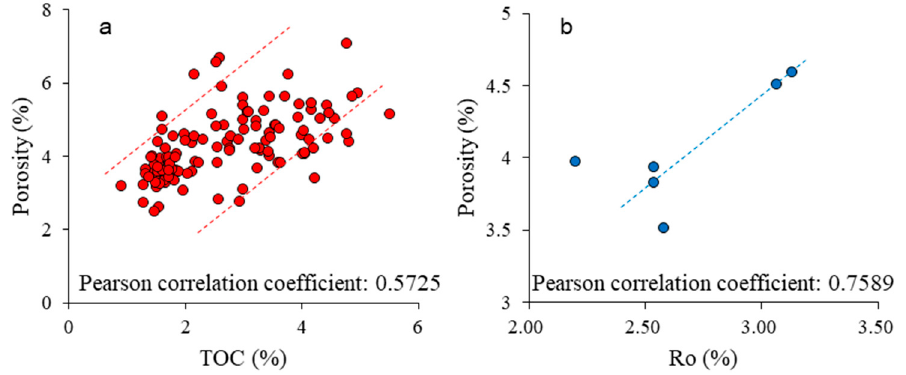
Figure 9. Relationship between ( a ) porosity and total organic carbon (TOC), ( b ) porosity and vitrinite reflectance (Ro) of Wufeng-Longmaxi Formation in Well A.